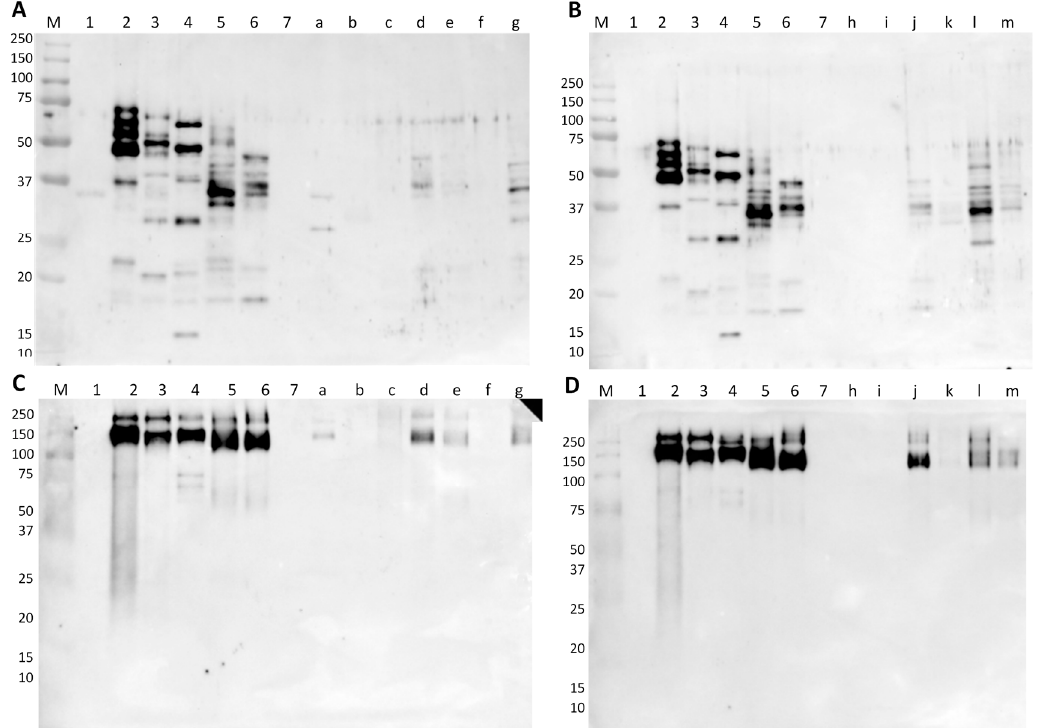
Figure 4. Immunoblot membranes for lupine testing using anti-gamma-conglutin polyclonal antibody in denaturing ( A , B ) and native conditions ( C , D ) with commercial and in-house-made samples. Legend: lane 1, SPI; lane 2, L. luteus ; lane 3, L. mutabilis ; lane 4, L. angustifolius ; lane 5, L. albus ; lane 6, 10% of L. albus in bread; lane 7, wheat bread (0% lupine flour); lane a, cereal bread; lane b, cookies; lane c, lupine biscuits; lane d, Pan Carré; lane e, “crostini”; lane f, lupine cookies with lemon flavor; lane g, flour for bread; lane h, cookies; lane i, chocolate wafers; lane j, model bread containing 2.5% of lupine flour; model bread containing 0.25% of lupine flour; lane l, flour mixture containing 2.5% of lupine in wheat; lane m, flour mixture containing 2.0% of lupine in rice; lane M, Precision Plus Protein Dual Color Standard 10–250 kDa.